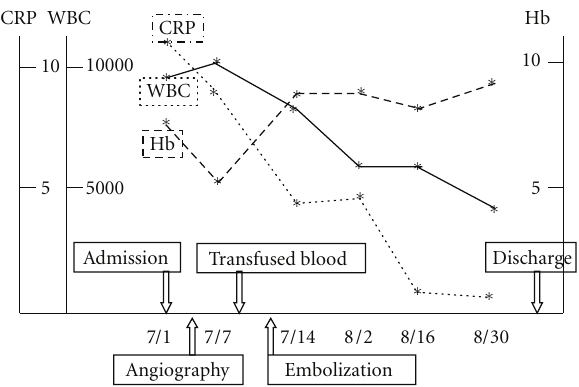
Figure 5: Laboratory results during hospitalization.